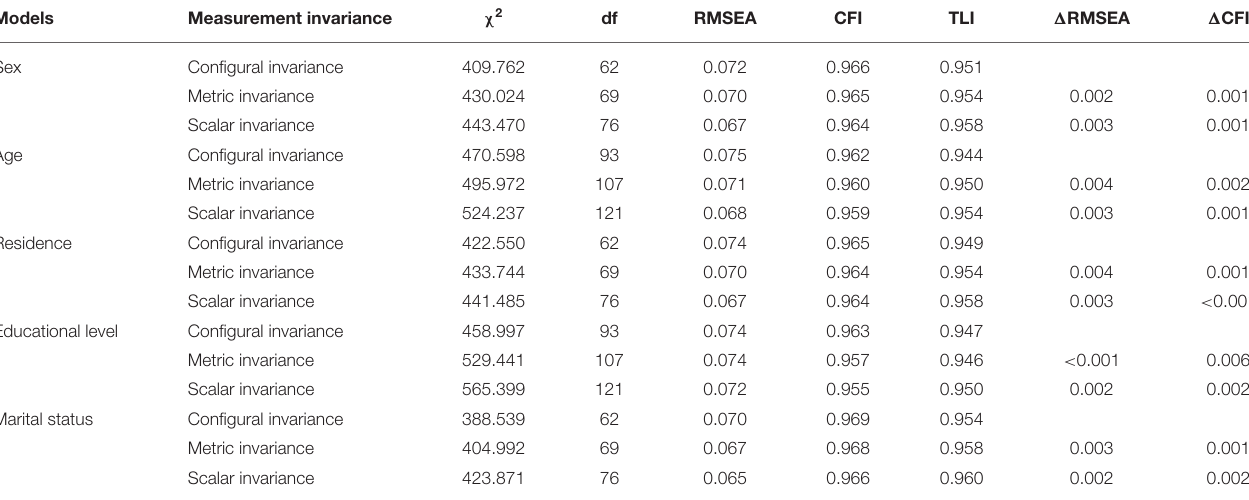
TABLE 5 | Measurement invariances across sex, age, residence, educational level, and marital status. Models